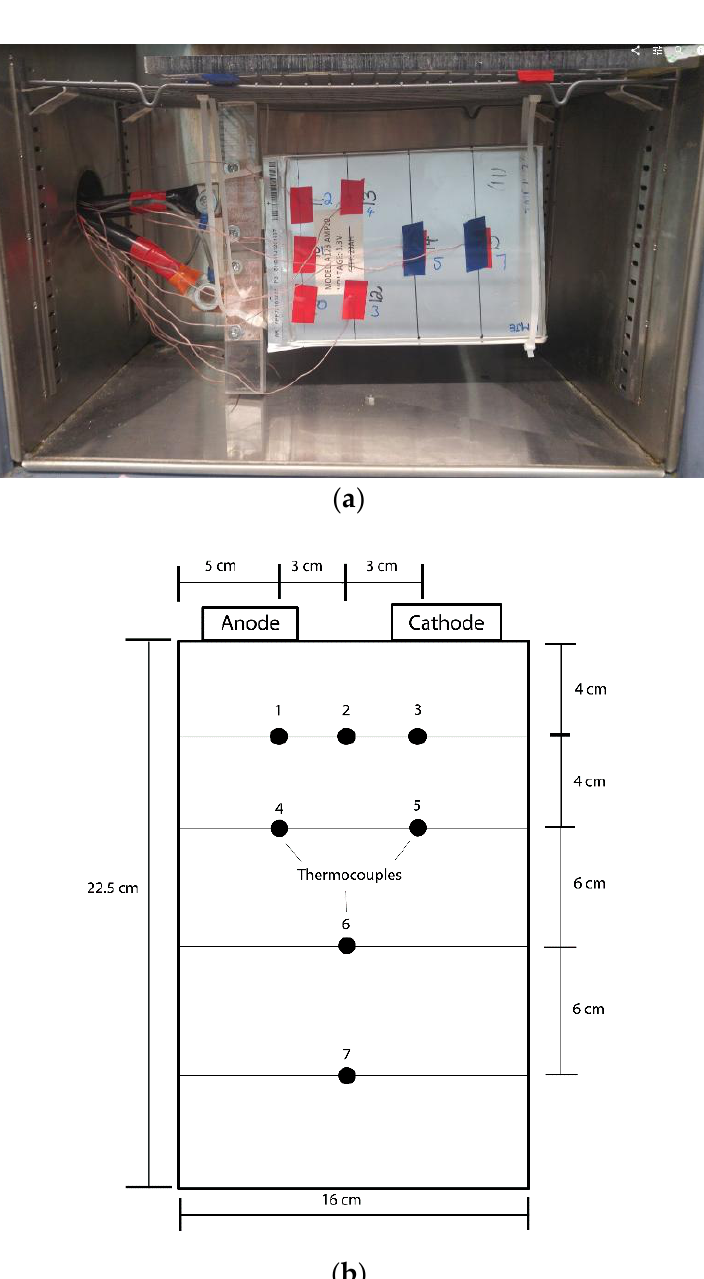
Figure 2. The experimental set-up of the LFP cell: ( a ) Picture of the cell inside the thermal chamber; ( b ) Schematic of the thermocouple placements on the LFP cell.